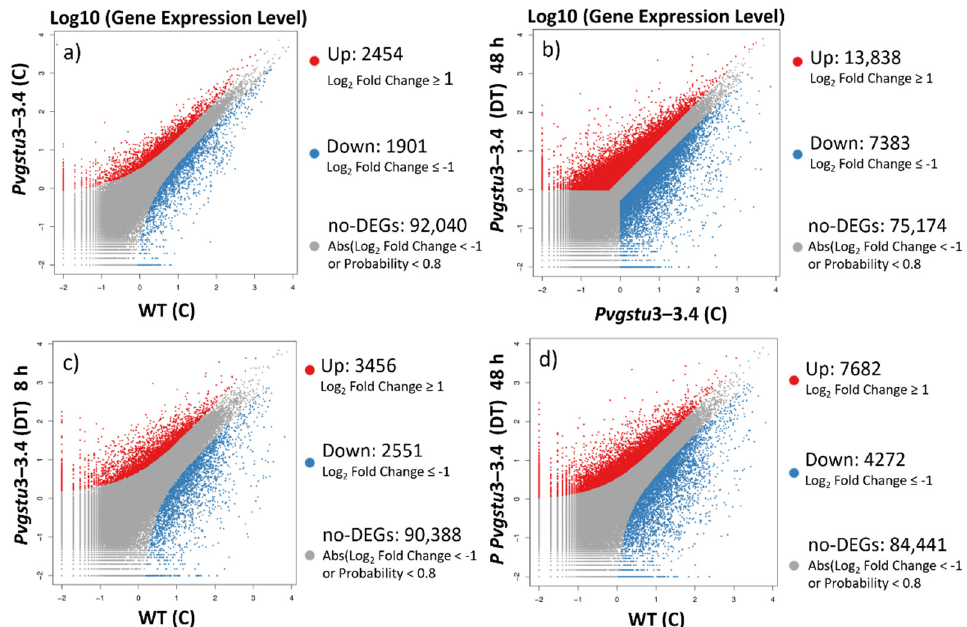
Figure 5. Scatter plot depicting the correlation of the gene expression profiles between ( a ) WT vs. Pvgstu3–3.4 in stress-free control (C) conditions (0 h; groups 1 vs. 2, respectively); ( b ) stress-free Pvgstu3–3.4 (C) vs. Pvgstu3–3.4 at 48 h under DT (groups 2 vs. 4, respectively); ( c ) stress-free WT (C) vs. Pvgstu3–3.4 at 8 h under DT (groups 1 vs. 3, respectively).; ( d ) stress-free WT (C) vs. Pvgstu3–3.4 at 48 h under DT (groups 1 vs. 4, respectively). DT indicates combined drought and heat stresses. The significantly up- and downregulated genes with probability ≥ and ≤ 0.8, respectively, are presented with red and blue dots, respectively, while non-significant genes as gray dots.